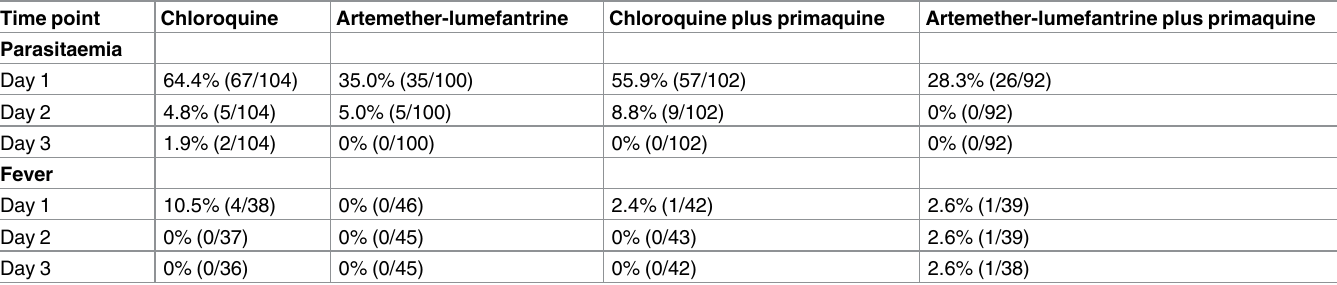
Table 4. Parasite and fever clearanceby treatment arm.